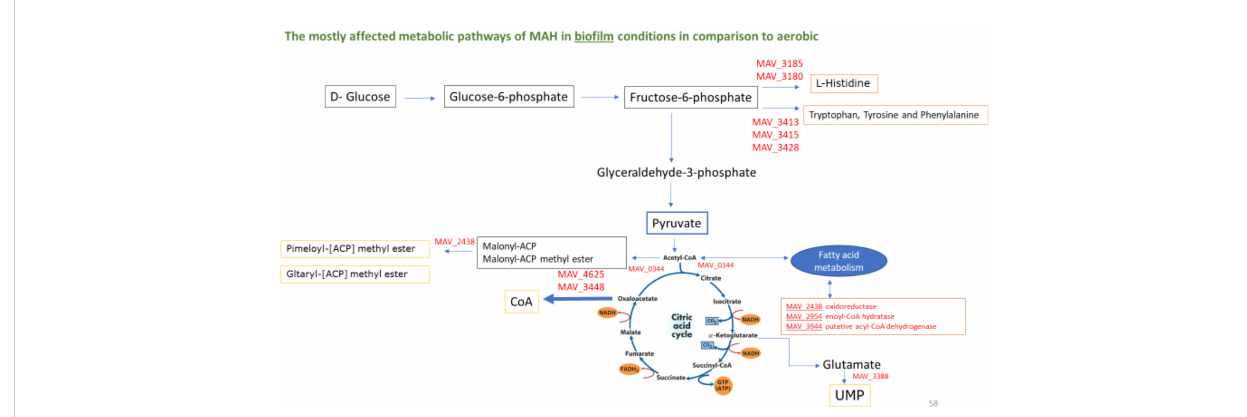
FIGURE 5 Biosynthesis of cofactors (Yellow Boxes), fatty acid metabolism (Brown Box) and amino acid metabolism (Orange Boxes) and entry into the TCA cycle during bio fi lm growth of M. avium. The represented enzymes were synthesized ≥ 1.5-fold over aerobic control. Fatty acid metabolism (MAV_2438 oxidoreductase, short chain dehydrogenase/reductase family protein, MAV_2945 enoyl-CoA hydratase/isomerase family protein, MAV_3944 putative acyl-CoA dehydrogenase).Biosynthesis of amino acids (MAV_0344 citrate synthase 2, MAV_3180 phosphoribosyl-AMP cyclohydrolase, MAV_3185 hisB; imidazoleglycerol-phosphate dehydratase, MAV_3413 aroQ; 3-dehydroquinate dehydratase, type II, MAV_3415 aroB; 3-dehydroquinate synthase, MAV_3428 aroE; shikimate-5-dehydrogenase). Biosynthesis of cofactors (MAV_0995 moaE; molybdopterin converting factor, subunit 2, MAV_2438 oxidoreductase, short chain dehydrogenase/reductase family protein, MAV_3388 pyrF; orotidine 5 ’ - phosphate decarboxylase, MAV_3448 2-dehydropantoate 2-reductase, MAV_4265 aldehyde dehydrogenase (NAD) family protein, MAV_4625